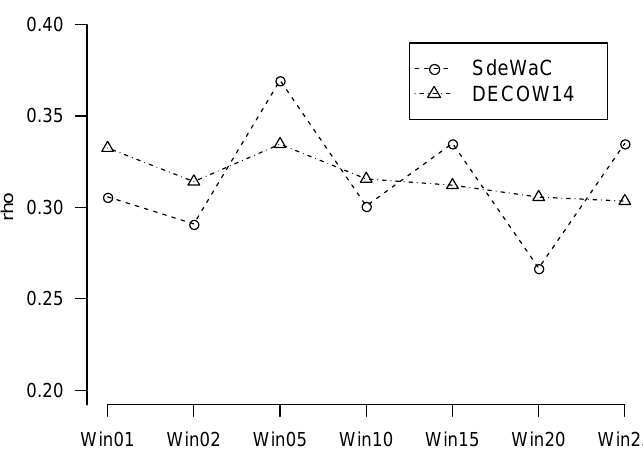
Figure 3: Results for GS1 with window models extracted from two different corpora: SdeWaC and DECOW14. The models rely on content words and use LMI